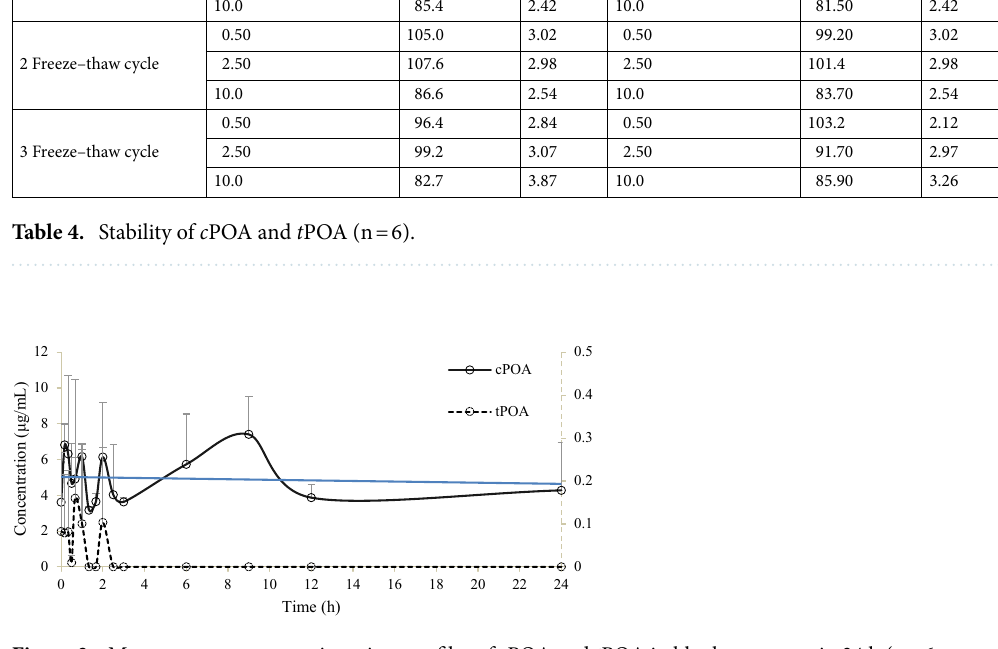
Figure 3. Mean serum concentration–time profiles of c POA and t POA in blank rat serum in 24 h (n = 6, mean ± SD). — shows mean serum concentration–time profiles of c POA, ---- shows mean serum concentration– time profiles of t POA.